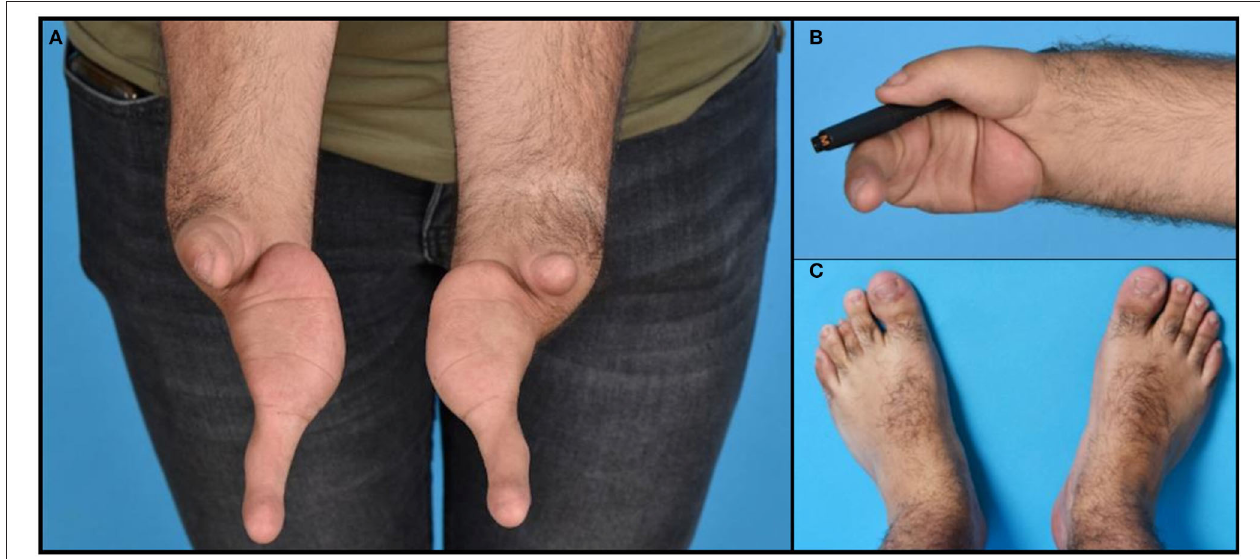
FIGURE 1 | Photographs of the hands (A) , feet (C) , and an example of functional use of the right hand holding a pen (B)